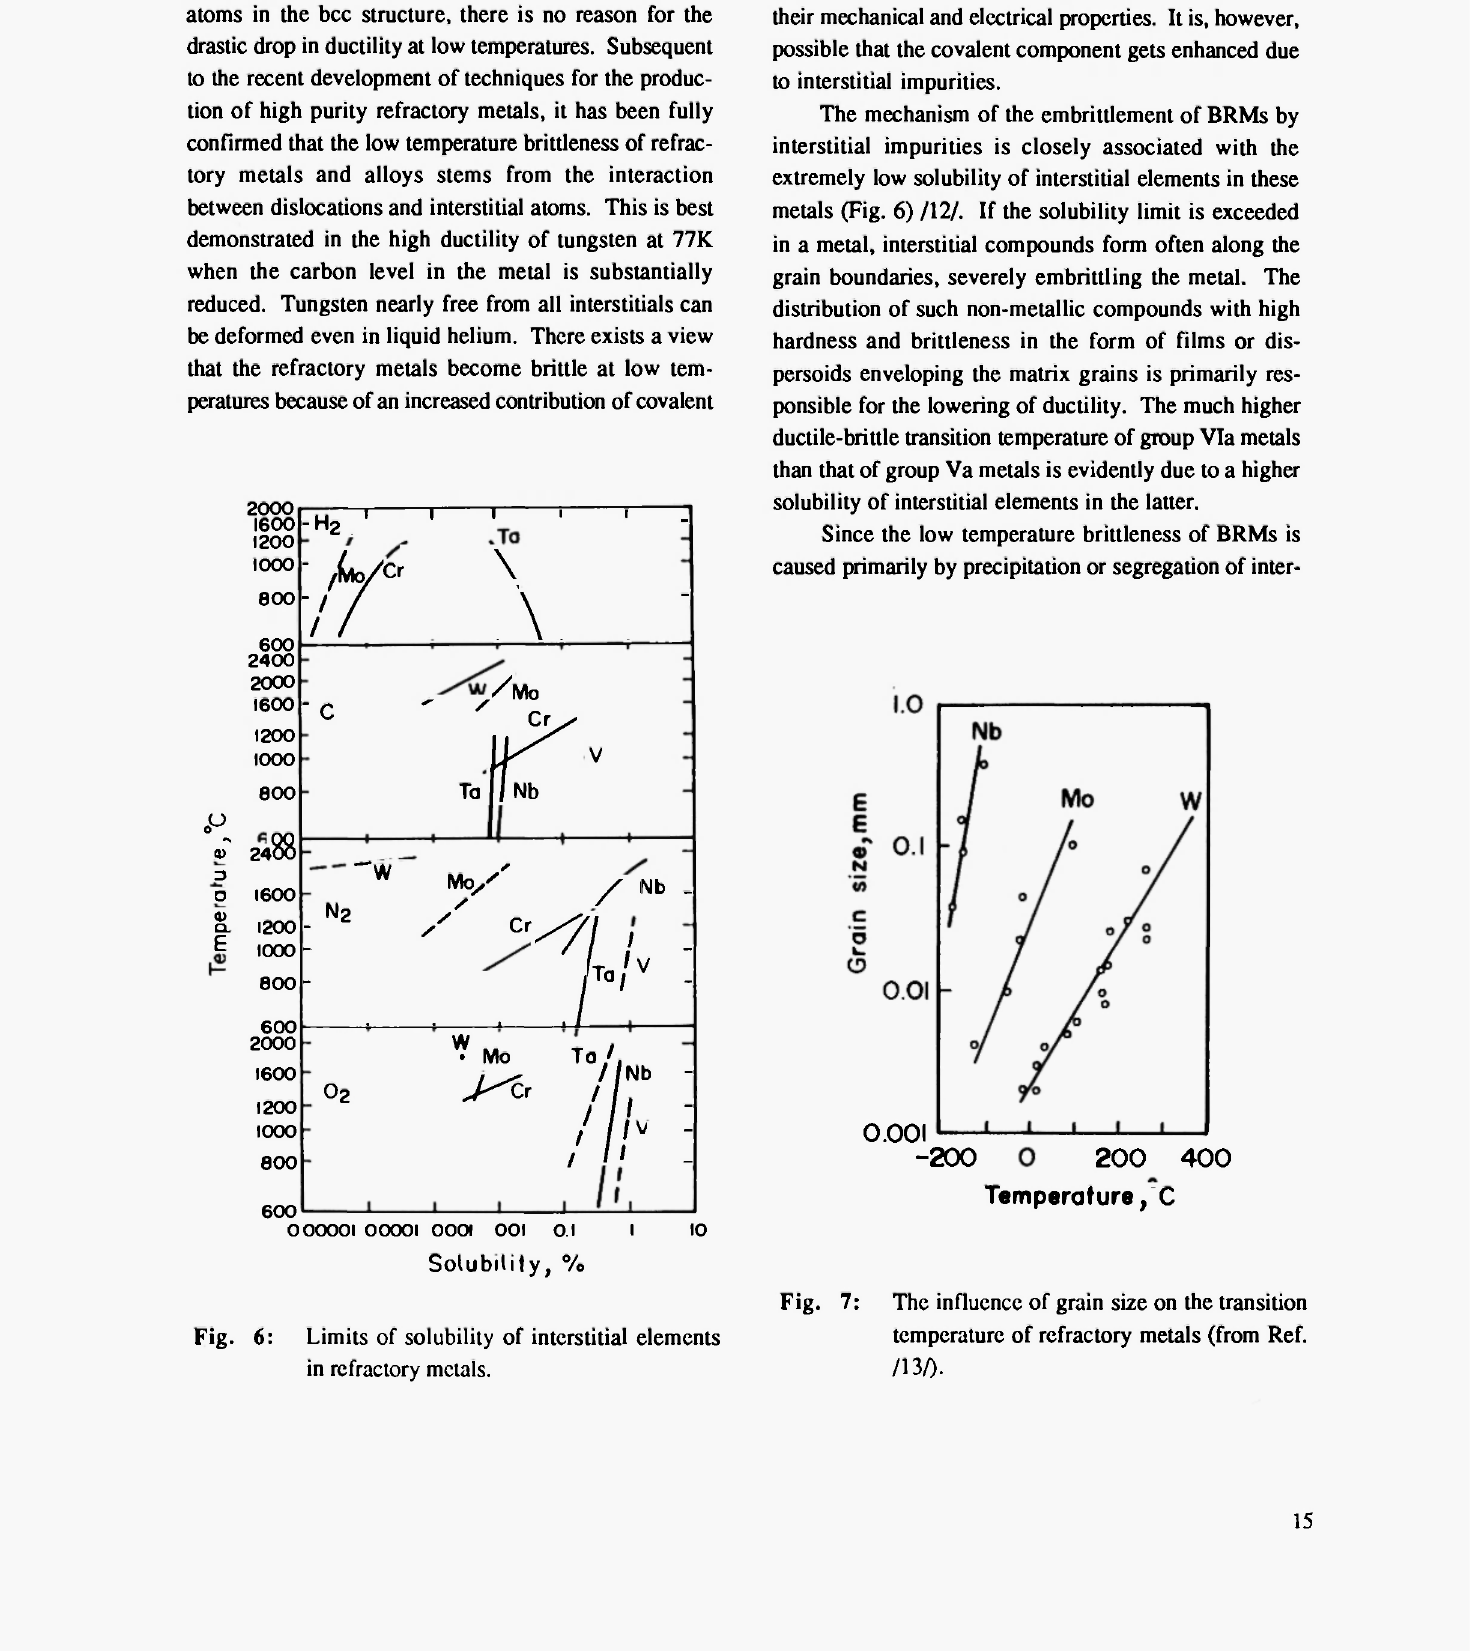
Limits of solubility of interstitial elements in refractory metals.